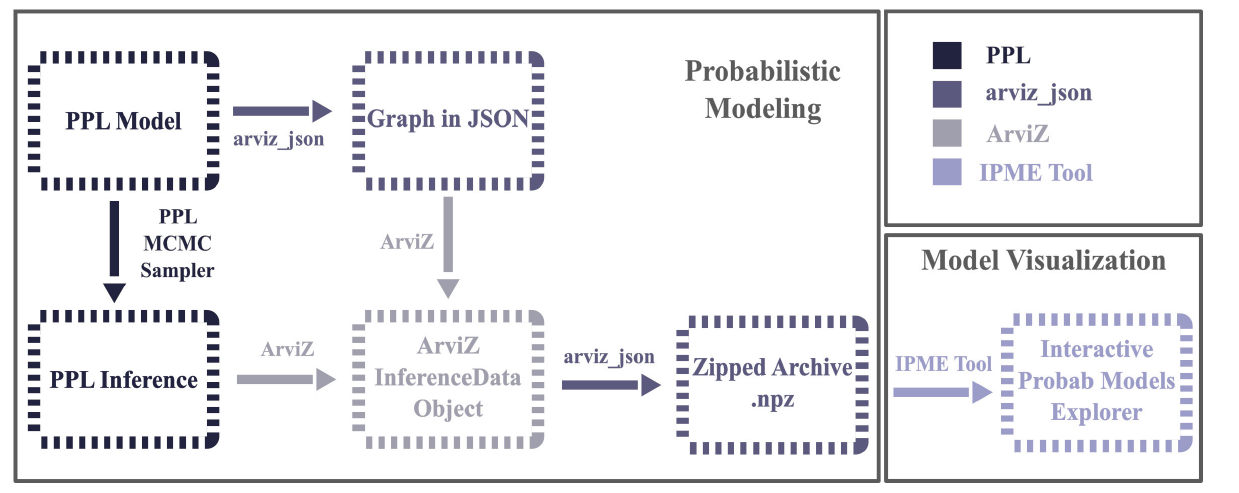
FIGURE 2 | Flowchart showing the steps that a modeler should take to export the PPL-specified probabilistic model and the inference data into a standardized output, which will then be used as an input to the IPME module. The proposed pipeline adds three new steps to the typical model specification and inference running routine; the export of the PPL model graph into a JSON structure; the export of the inference data into an ArviZ InferenceData object, where we attach the structured description of the graph from the previous step; and finally, the export of all these into a collection of .npy arrays and metadata in a zipped file. We provide a concrete implementation of this pipeline through the arviz_json module, which was created for providing a standardized output for the PyMC3 models and inference